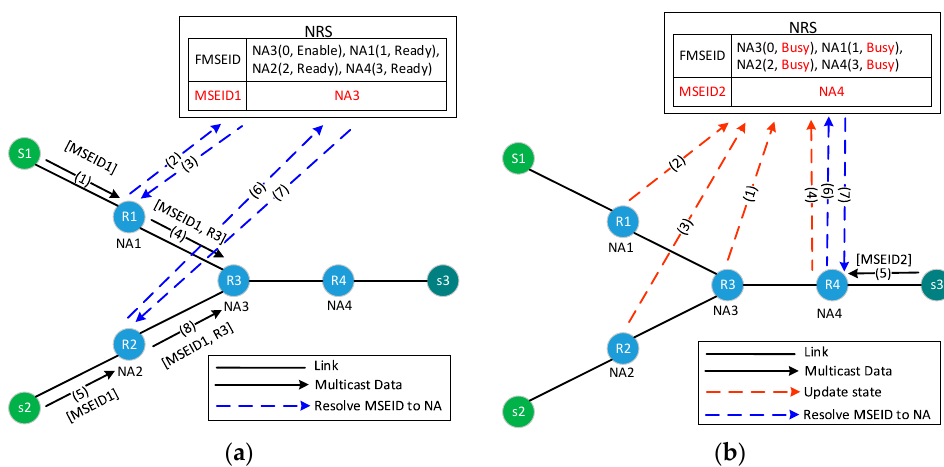
Figure 2. The example of core discovery and selection process. ( a ) The core discovery and selection process of S1 and S2; ( b ) the core discovery and selection process of S3.